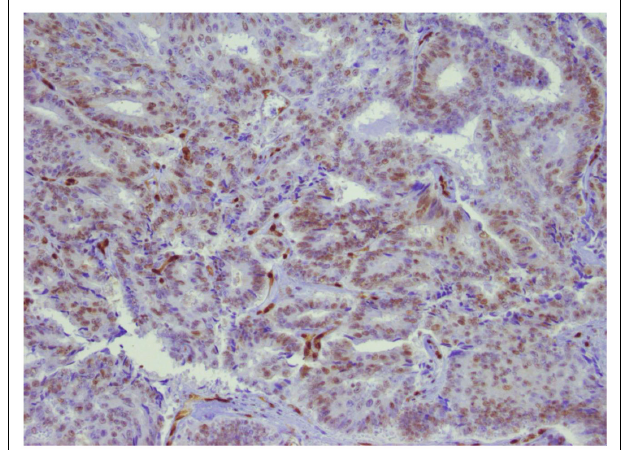
FIGURE 3 | ERG expression in prostate tumor . Immunohistochemical analysis of the primary tumor. ERG expression is indicated by brown chromogen in the nucleus. Blue represents hematoxylin